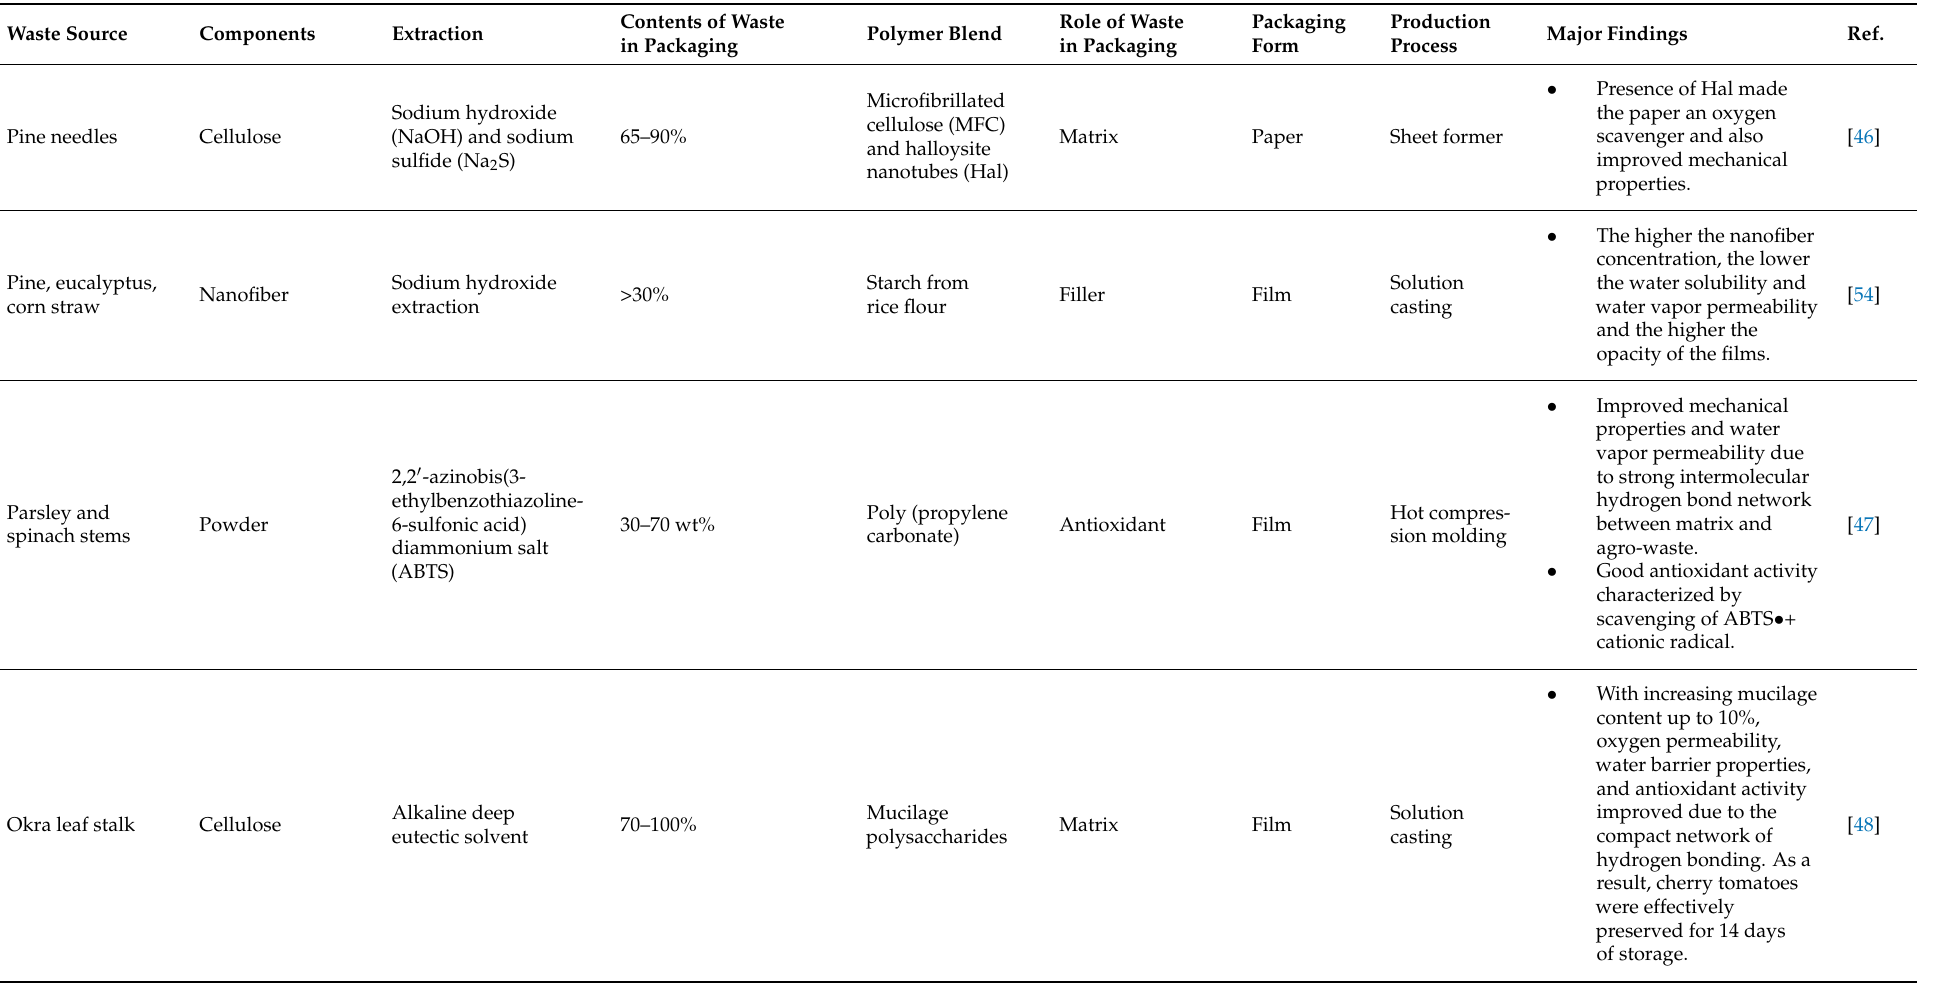
Table 2. Packaging developments utilizing crop